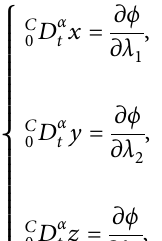
� 0 . 0002 , C � 0 . 0005 , C � 0 . 0003 , 1 2 3